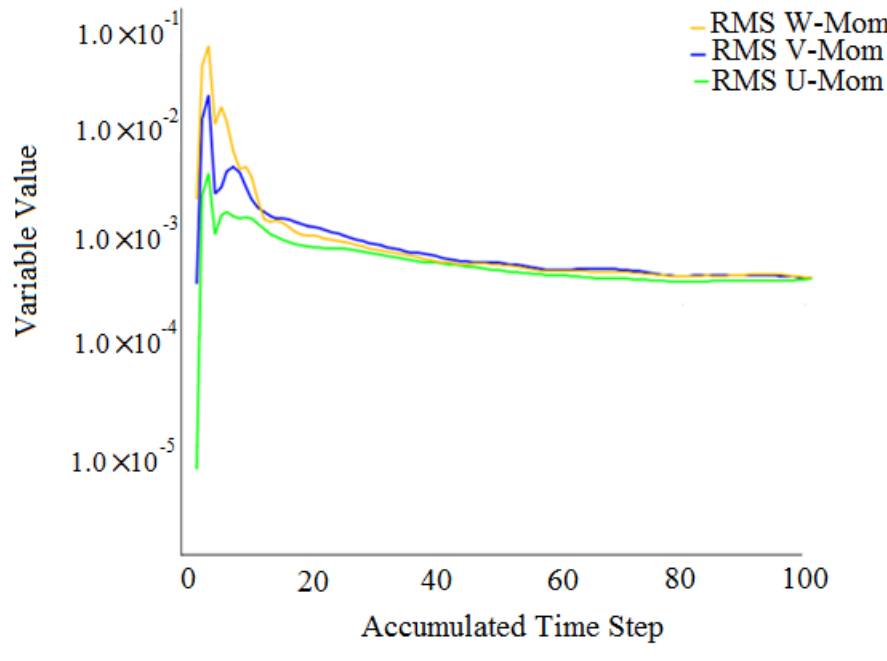
Figure 4. Convergence results .